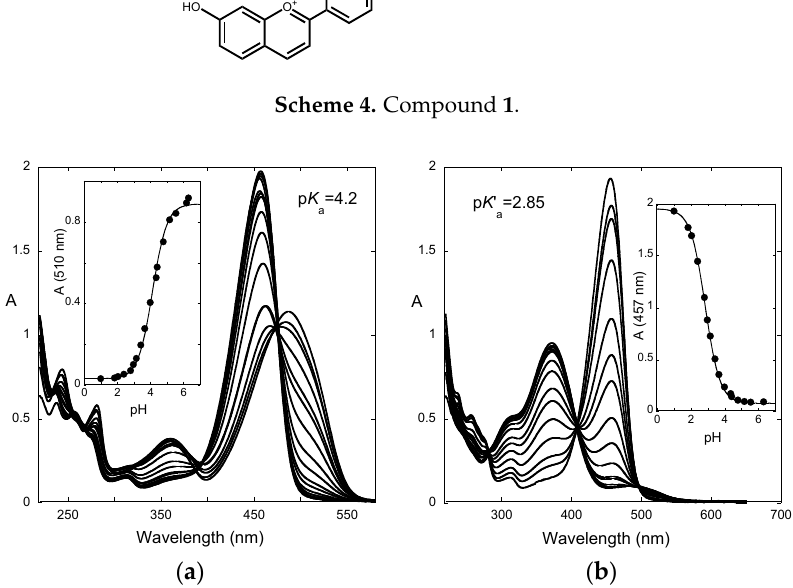
Figure 1. ( a ) Absorption spectra of compound 1 taken immediately (circa 1 min) after a direct pH jump; ( b ) the same at the equilibrium.